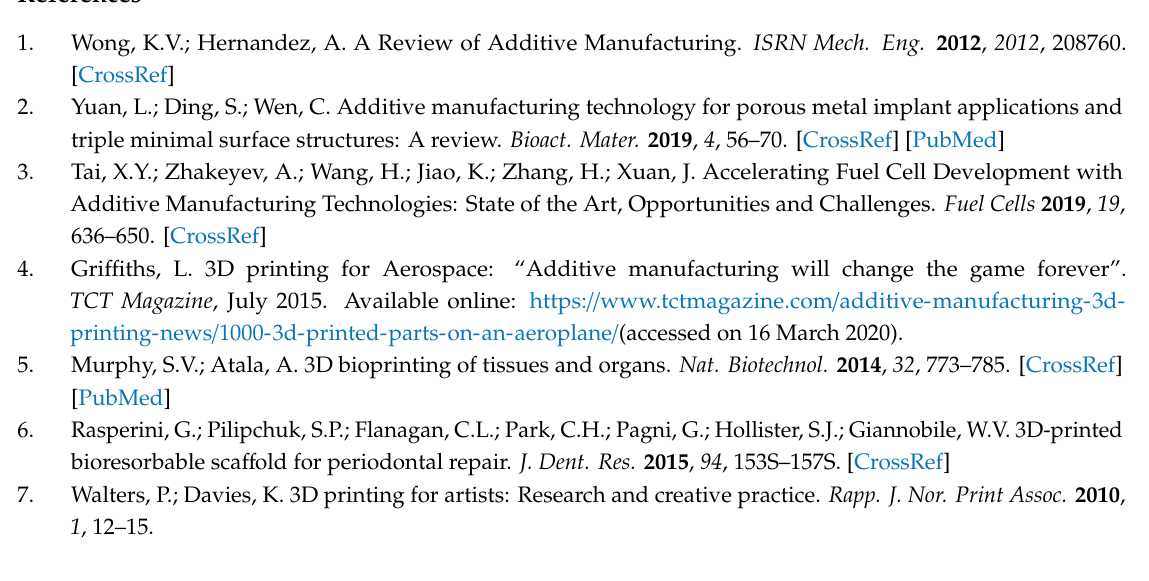
Figure S1: Photos of anolyte precipitates from a nickel coated anode after two weeks of running: (left) top view, (right) side view of the container after removing the MFC components; and Figure S2: Assembled MFCs for anode material test: (left) MFC unit assembly and (right) experimental set